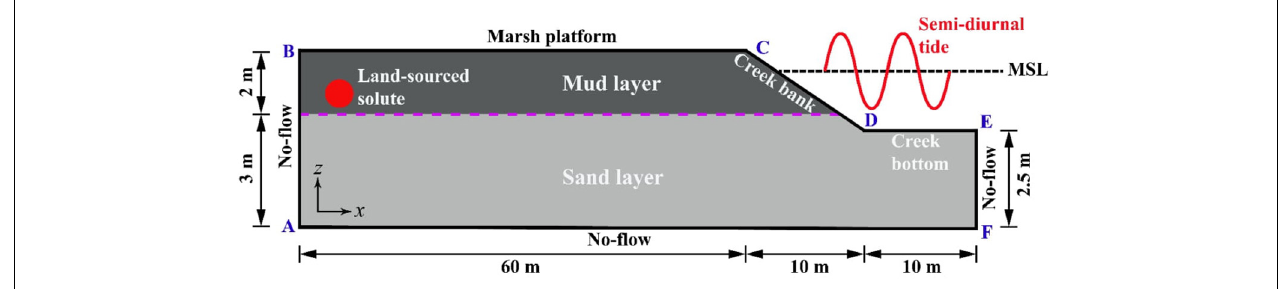
FIGURE 1 | Schematic diagram of the numerical model domain representing a 2D creek-normal transect and corresponding boundary conditions.